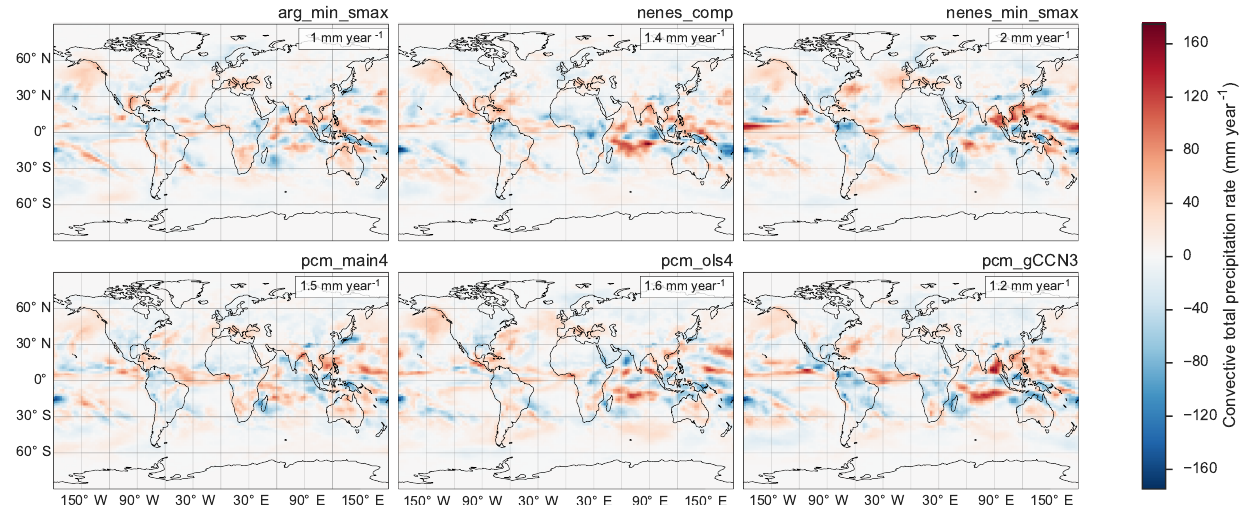
Figure 11. Absolute difference between present-day annual average convective precipitation for each of the indicated simulations versus the arg_comp reference simulation.